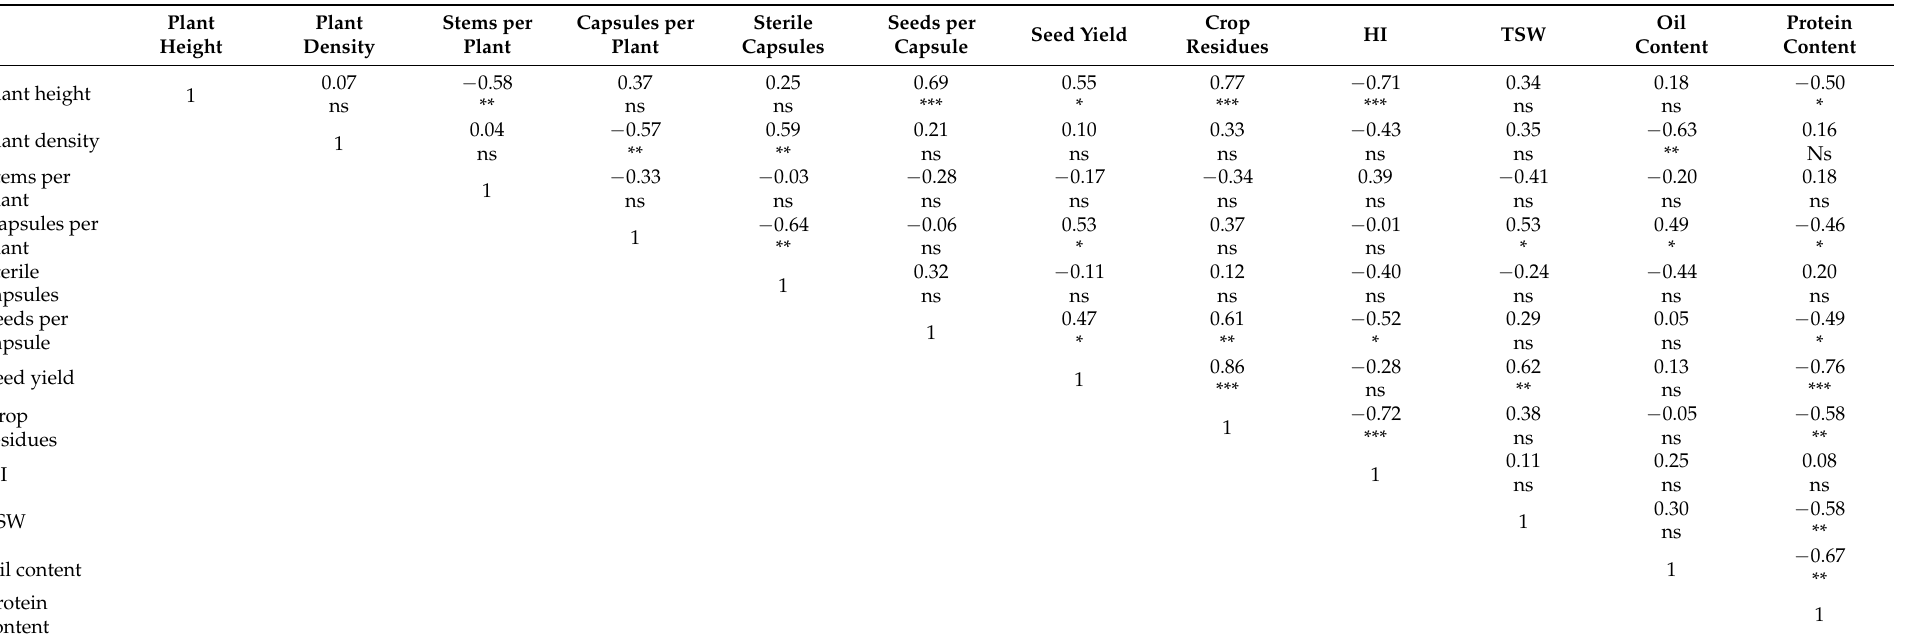
Table 6. Pearson’s correlation coefficients and their statistical significance among studied parameters among pairs of variables related to the expression of growth, yield, and qualitative traits in five linseed genotypes under two sowing dates and cultivated in two different